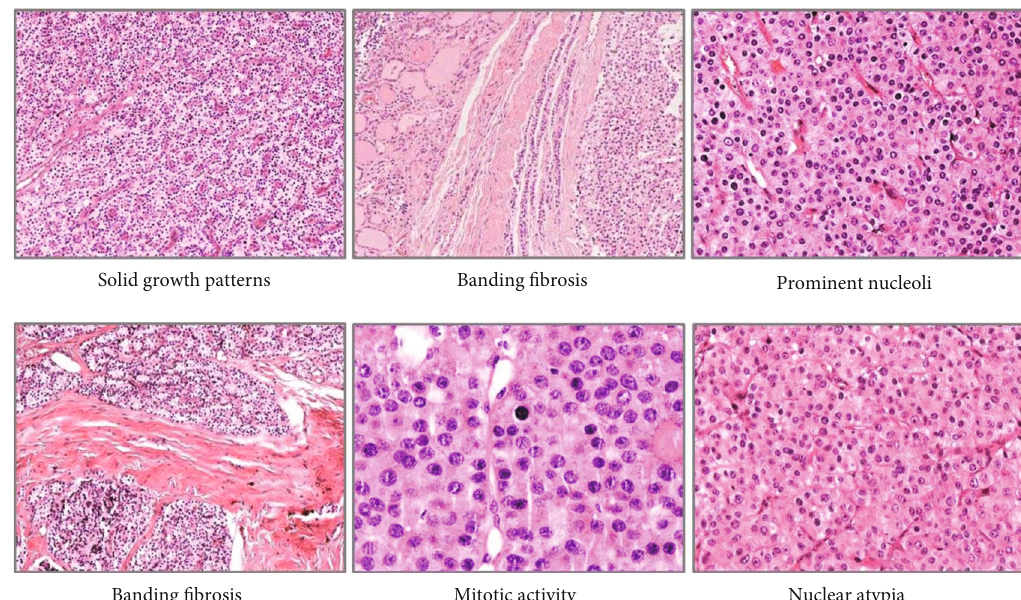
Figure 1: Histopathological characteristics of atypical parathyroid